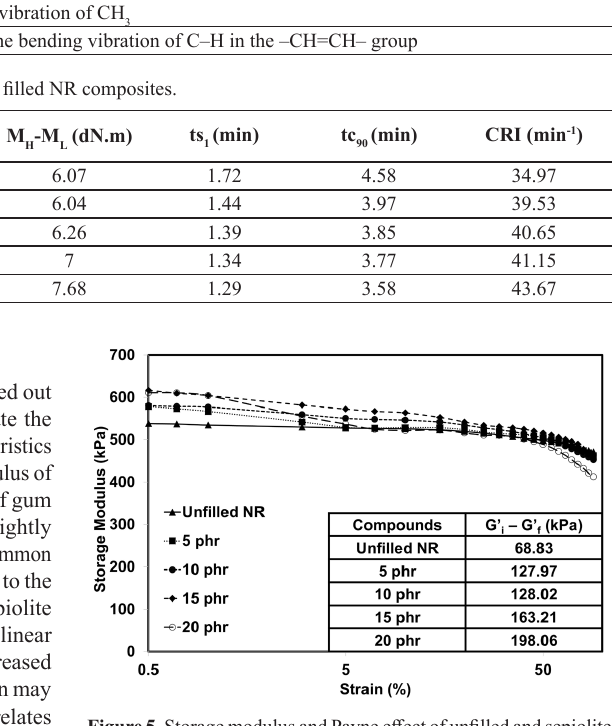
increasing the damping behavior. This is simply due to the dilution effect due to the replacement of sepiolite over the elastic rubber 22,23 .